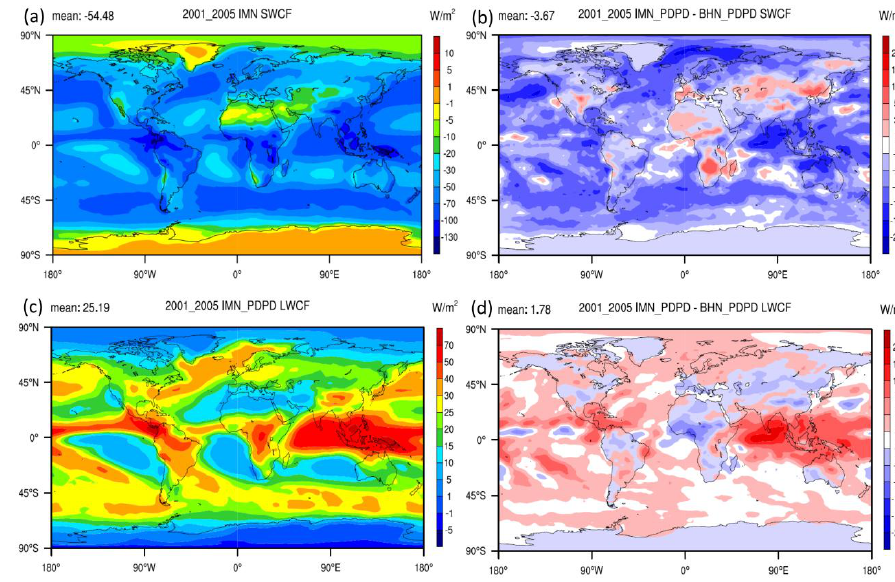
Figure 5. Fig. 5. Horizontal distribution of total SWCF and LWCF based on IMN and the corresponding differences between IMN and BHN